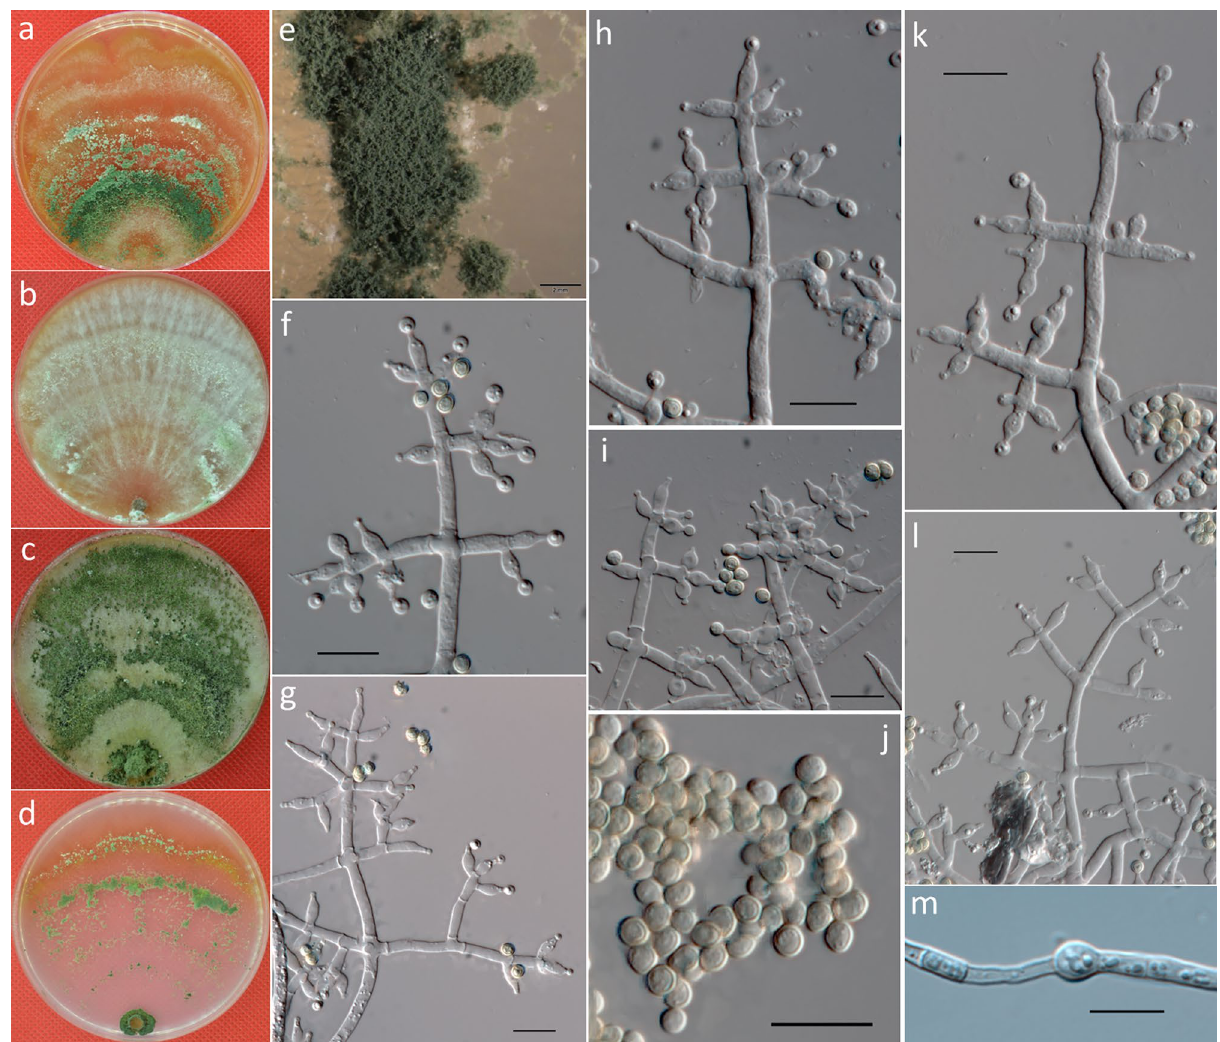
Figure 5. Cultures and asexual morph of Trichoderma atrobrunneum . ( a–d ) Cultures at 25 °C [( a ) on CMD, 7 days; ( b ) on MEA, 4 days; ( c ) on PDA, 15 days; and ( d ) on SNA, 7 days]. ( e ) Conidiation tuft (SNA, 7